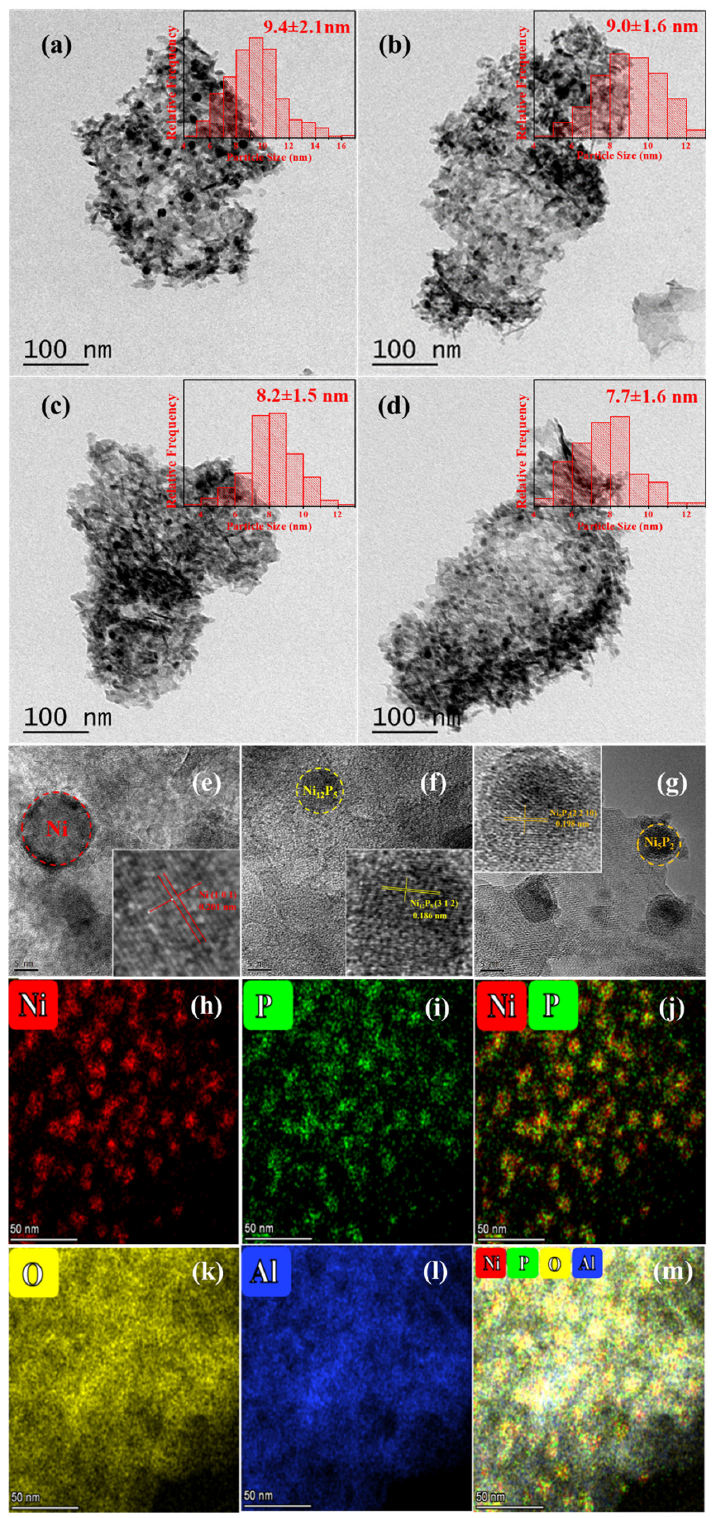
Figure 2. TEM images and corresponding size distributions of reduced ( a ) Ni/Al 2 O 3 ; ( b ) NiP-4/Al 2 O 3 ; ( c ) NiP-3/Al 2 O 3 ; ( d ) NiP-2/Al 2 O 3 ; ( e – g ) HRTEM image (the inset is the magnified image of Ni, Ni 12 P 5 and Ni 5 P 2 ) for reduced NiP-2/Al 2 O 3 catalyst; and ( h – m ) elemental mapping results for reduced NiP-2/Al 2 O 3